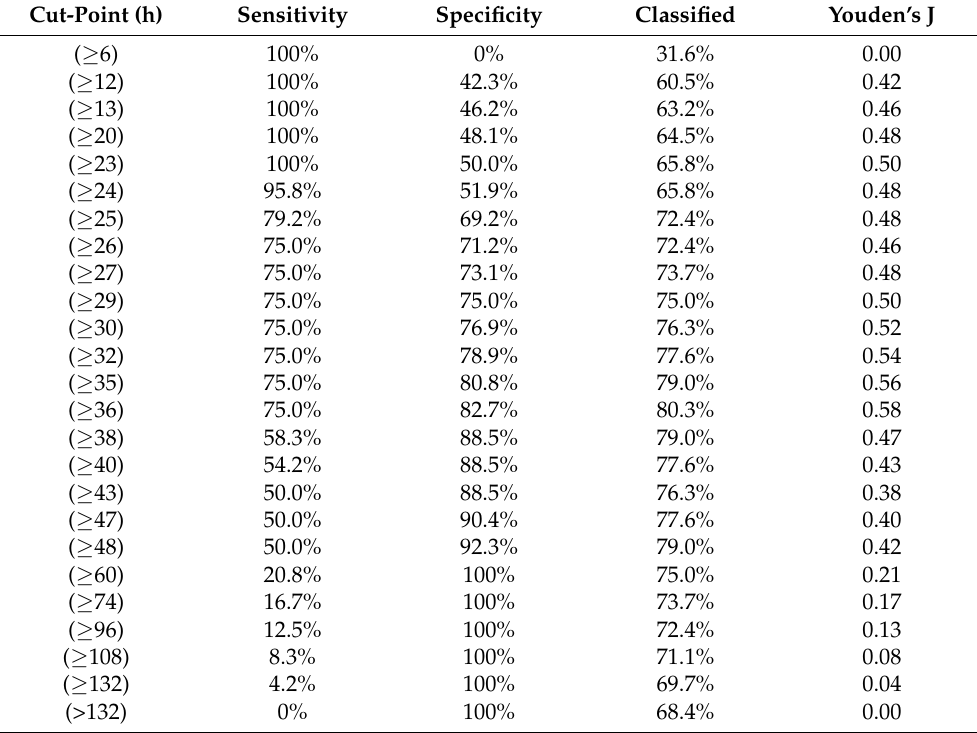
Table 5. Sensitivity and specificity of different cut-off points to prevent the onset of moderate-to- severe phlebitis in dogs.